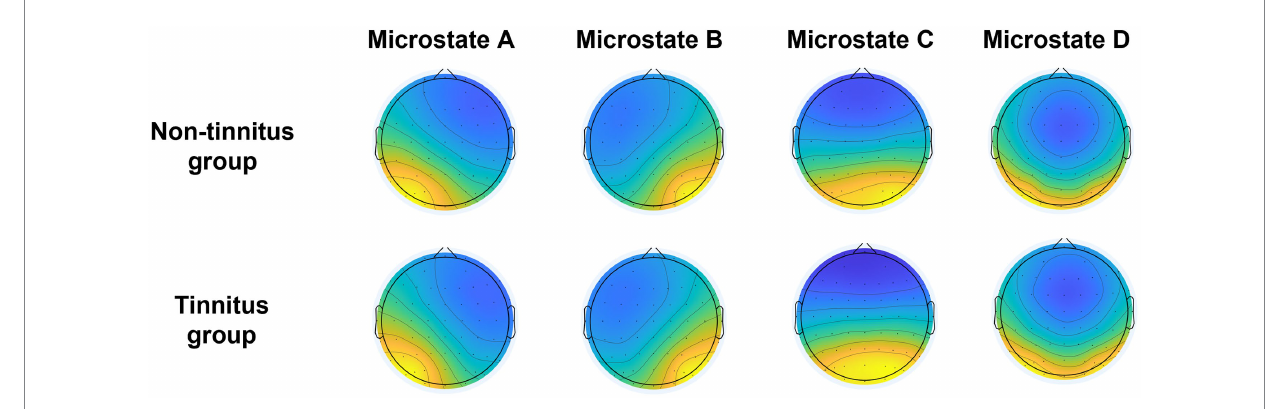
FIGURE 1 Topological maps of clustering microstates of the non-tinnitus group and the tinnitus